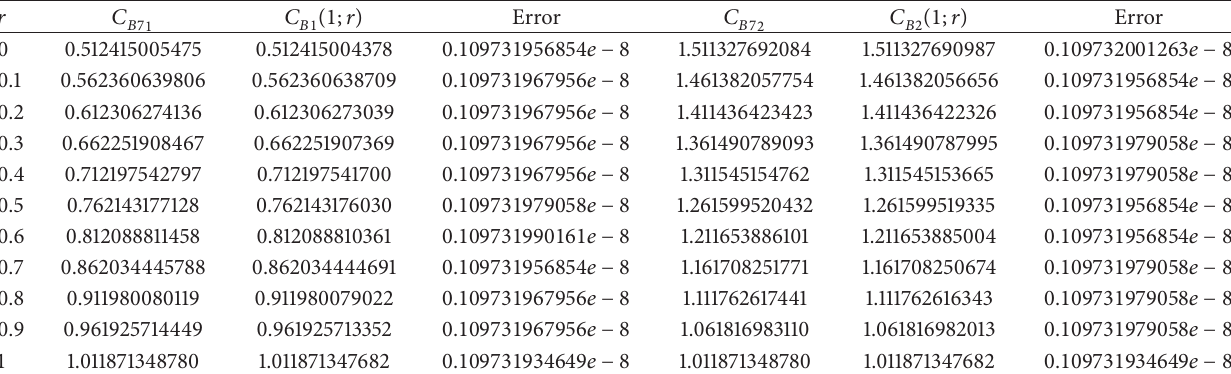
Table 2: The result of the proposed method for Example 27 with V = 𝛼 = 0.75 , 𝑚 = 7 , 𝑘 1 = 0.012 , and 𝑘 2 = 0.001